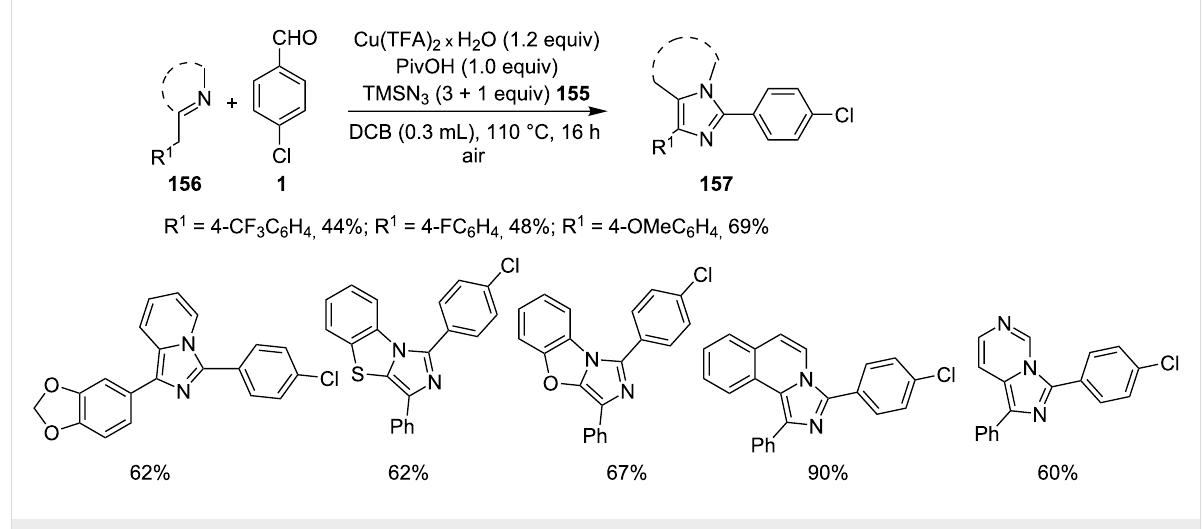
Scheme 57: Wider substrate applicability for the